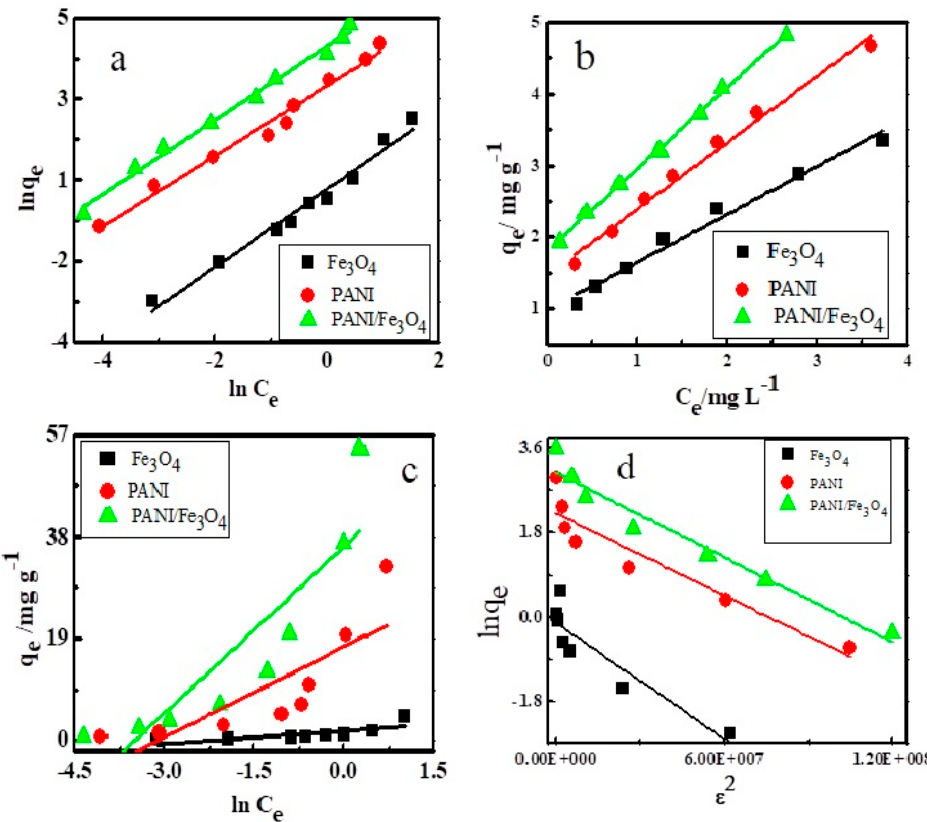
Figure 7. Adsorption of BB3 on Fe 3 O 4 , PANI, and PANI / Fe 3 O 4 . ( a ) Freundlich, ( b ) Langmuir, ( c ) Tempkin, and ( d ) D-R adsorption isotherms.